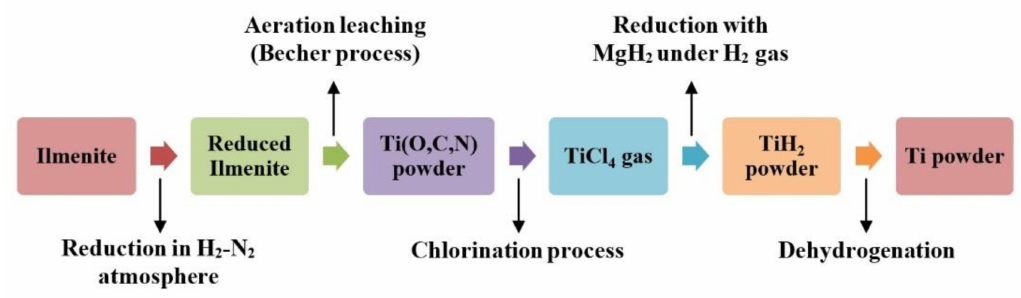
Figure 1. Schematics of a proposed process of Ti powder production from